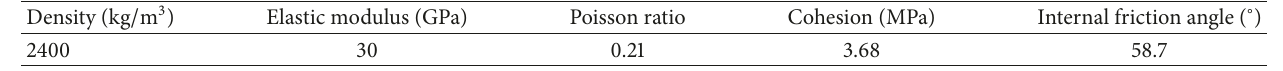
Table 2: Mechanical parameters for the structure.